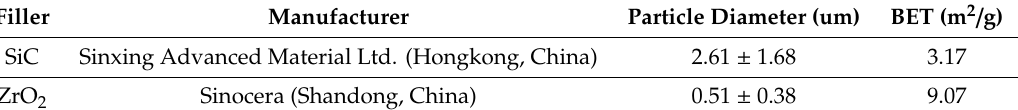
Table 2. Ceramic fillers used in the study and their fundamental properties.